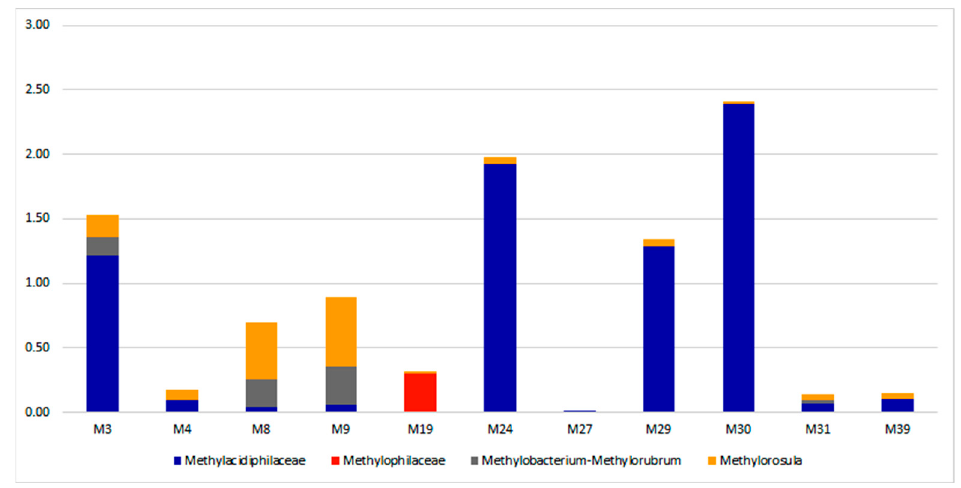
Figure 7. Distribution patterns of methylotrophs retrieved from the peat samples.